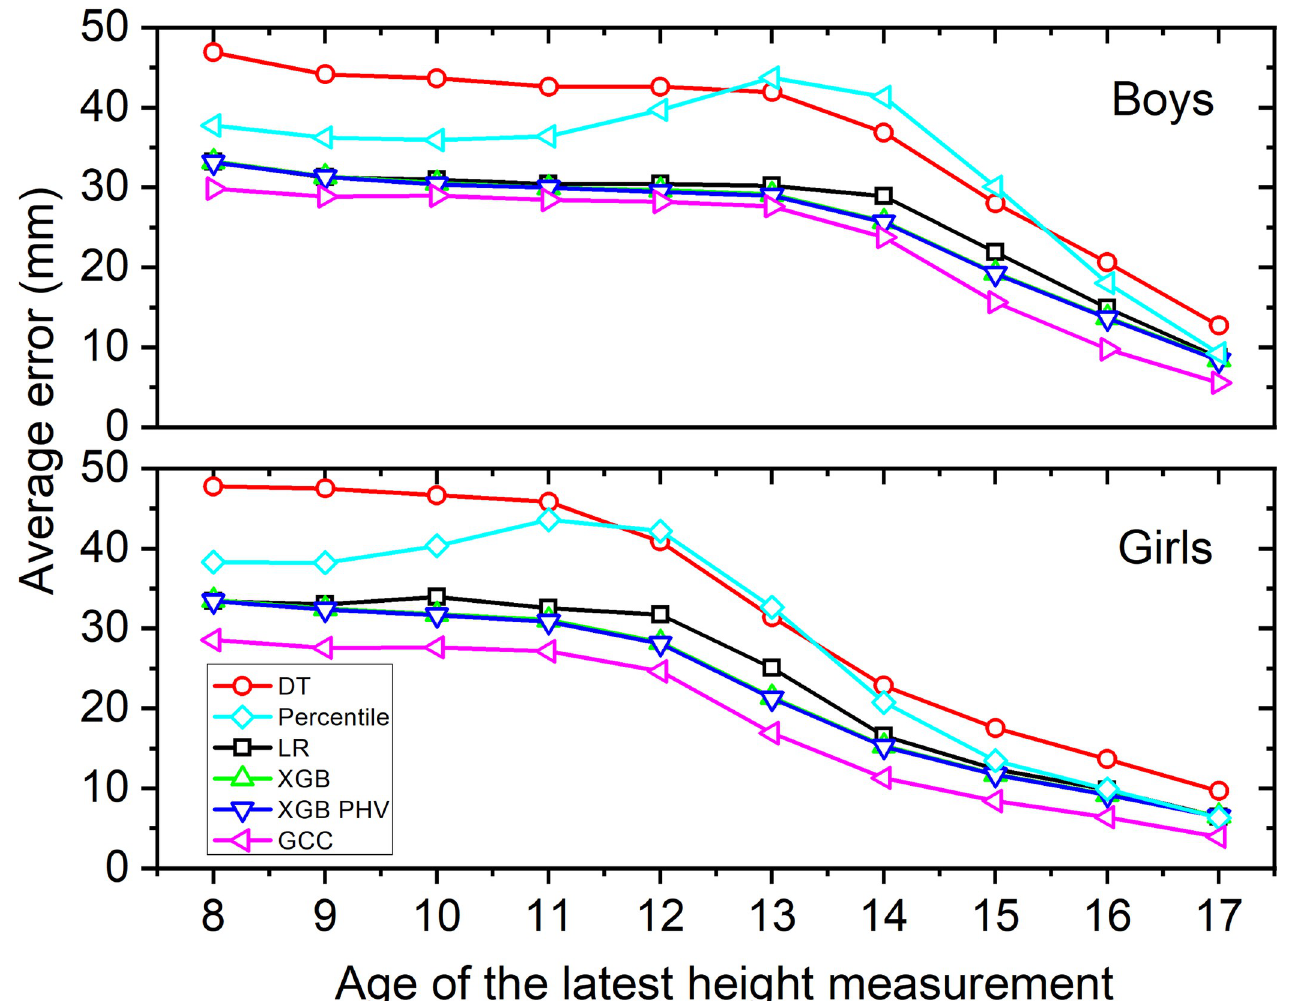
Fig 3. Average error (in mm) for predicting the mature height for boys and girls for six different models (LR = linear regressor, DT = decision tree regressor, XBG = extreme gradient boosting, XGB PHV = XGB using PHV as an additional feature, Percentile = percentile method, GCC = Growth Curve Comparison method), as a function of the year up to which the height data is